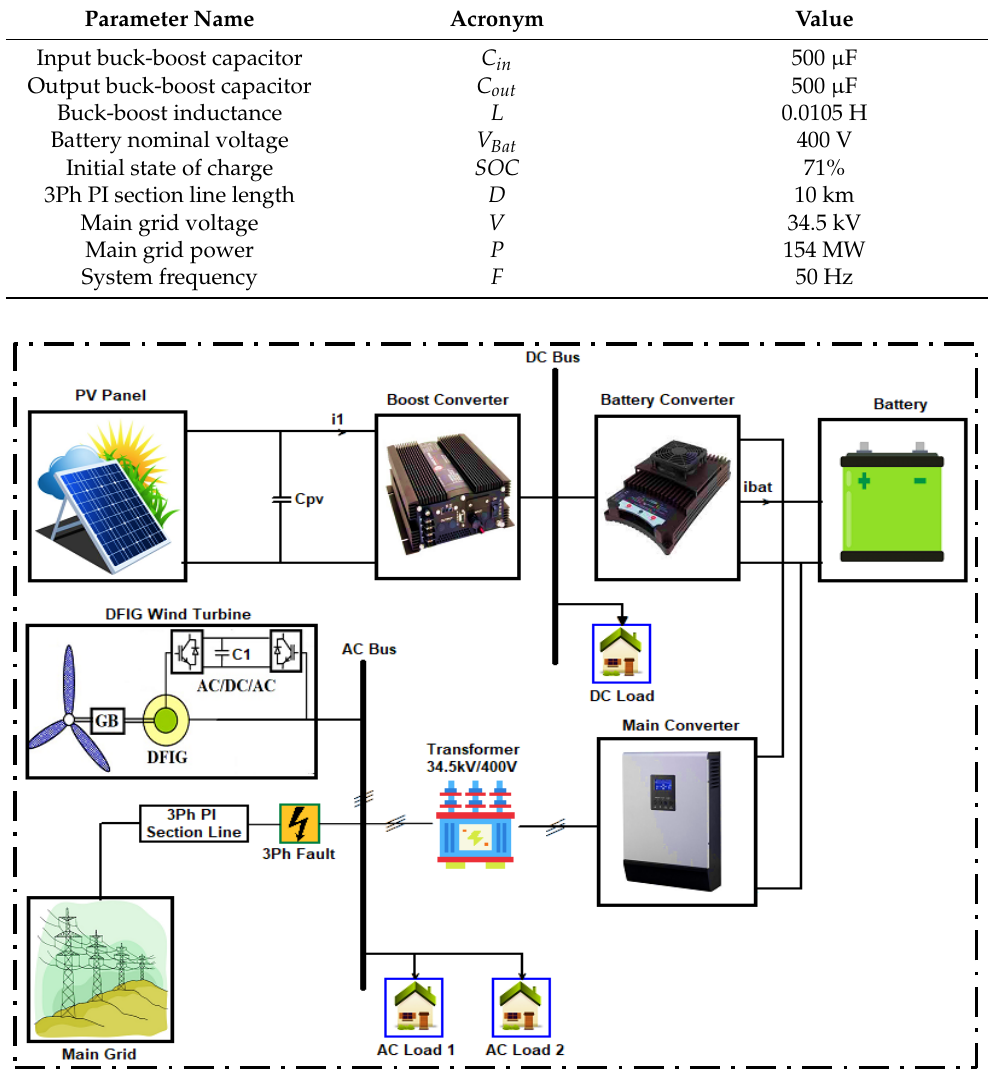
Figure 1. A diagrammatic illustration of the proposed hybrid AC/DC MG. Table 1. The MG